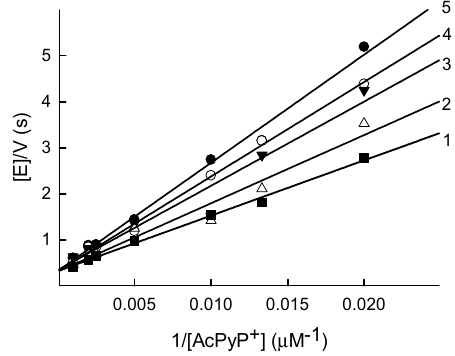
Figure 3. Steady-state kinetics of the reduction of 3-acetylpyridineadenine dinucleotide phosphate by Pf FNR. NADPH concentrations: 200 µM (1), 150 µM (2), 100 µM (3), 50 µM (4) and 25 µM (5).